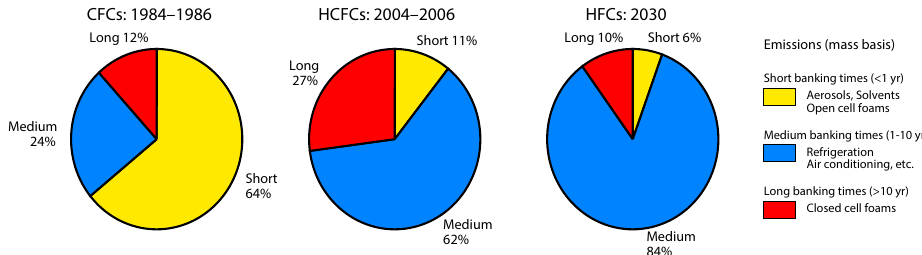
Fig. 1. Contributions of different types of applications to the emissions (mass basis) of CFCs, HCFCs, and of HFCs. The applications differ in the delay times between production and emission (banking times; see Table 1). The CFC and HCFC emissions (AFEAS, 2009) are shown for those years when they were used extensively and reductions in their emission were not affected much by Montreal Protocol regulations. HFC emissions are the average of the upper- and lower-range scenarios for 2030 from Velders et al. (2009).